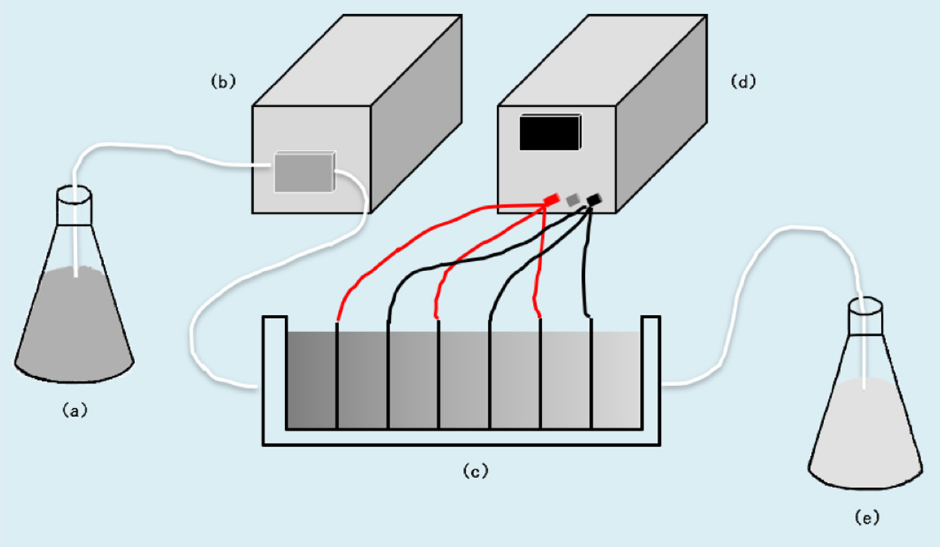
Figure 1. A schematic diagram showing the device layout used in the experiments: ( a ) suspension, ( b ) pump, ( c ) capture pool, ( d ) power, and ( e ) effluent.